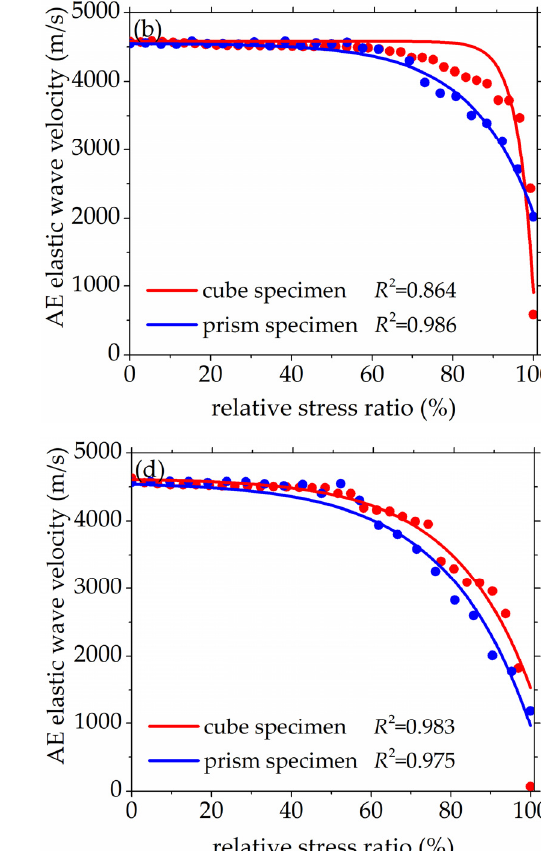
Figure 6. The relationship between AE elastic wave velocity and relative stress ratio with different volume fractions of